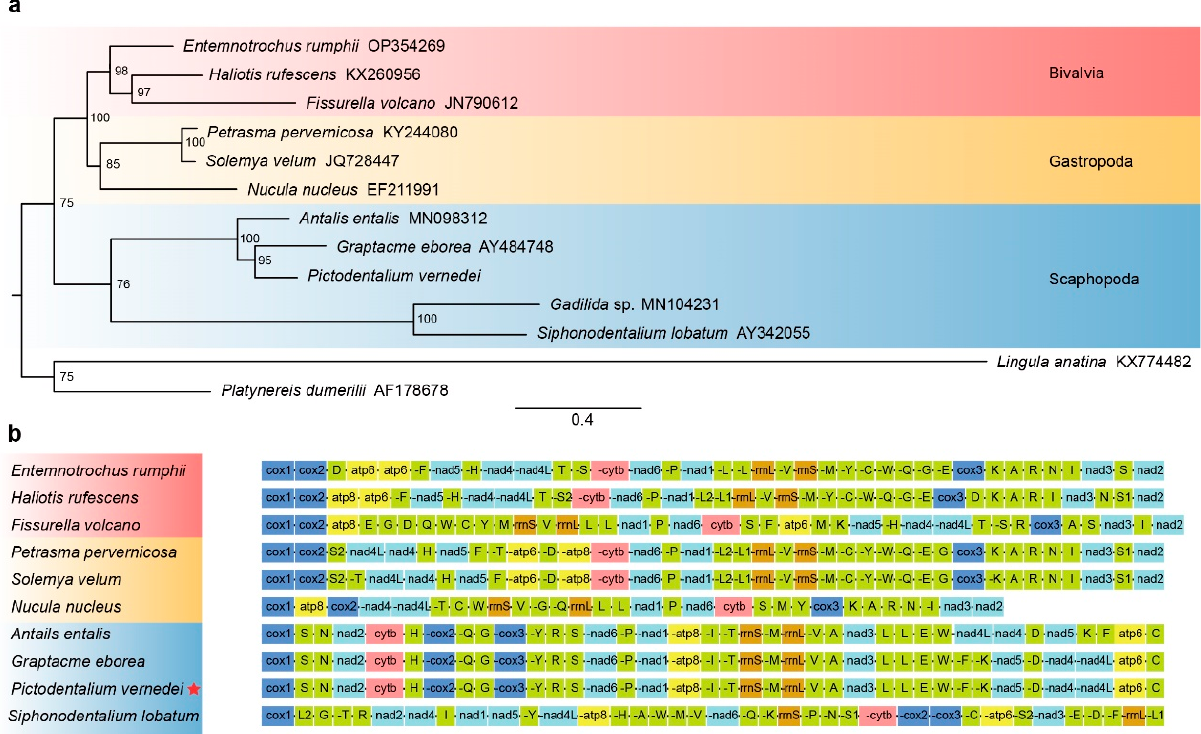
Figure 4. Phylogenetic tree ( a ) and gene orders ( b ). ( a ) Three protobranch bivalves, three veti- gastropods, five currently available scaphopods, and 2 outgroup species were selected, and the phylogenetic tree was constructed based on the amino acid sequences from 13 protein-coding genes. Bootstrap (BS) support values are shown at each node. ( b ) Gene order of PCGs among Vetigastropoda, Protobranchia, and Scaphopoda. Gadillida sp. was not included as its assembly and annotation are not complete. The arrangement graph is visualized by iTOL and the boxes with different colors and labels represent different gene